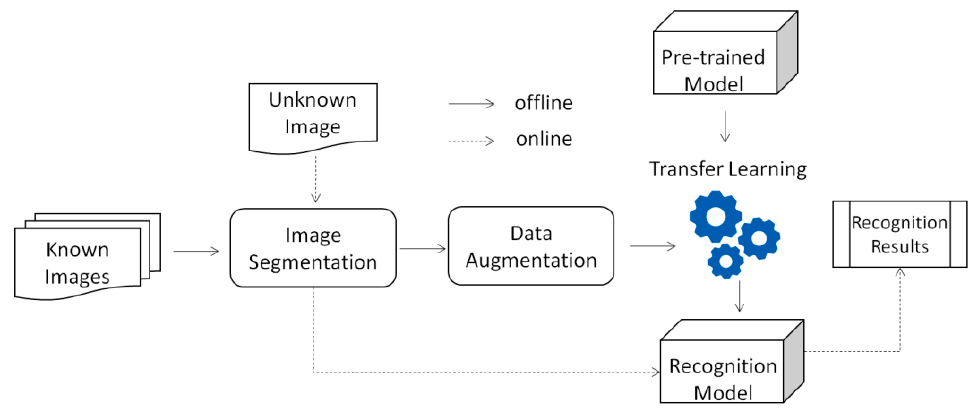
Figure 2. Framework of the proposed method.